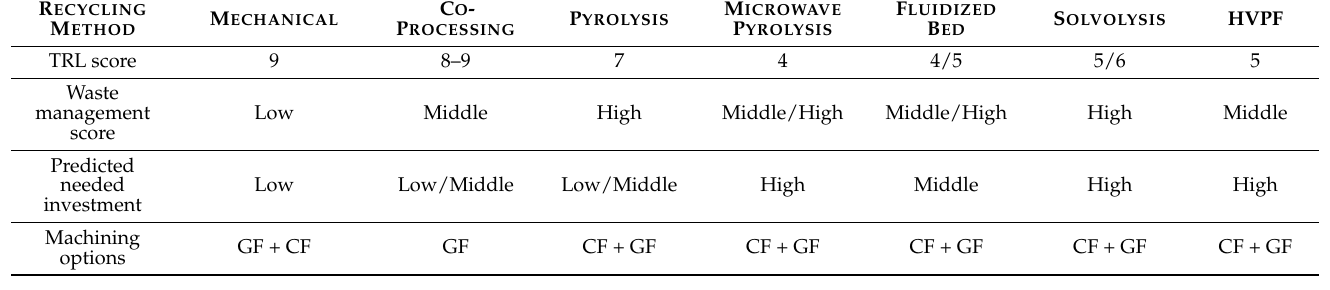
diagram overview. The different scores are evaluated based on comparisons between other research [26,27,31,49,50], the rating from the European waste hierarchy and through communication with the affected industries. The waste management score is categorized into three groups, low, middle and high, which is based on the properties of the various processes, output and TRL but, in particular, on the residual material value, which will be described more Section 4.1. These costs are also indicated and evaluated in the papers from Europe Wind and EtipWind [1,30]. The individual score is indicative and varies among EU recyclers using the same recycling method due to varying processing parameters, capacity and throughput. Table 1. Overview of the current recycling methods (Reproduced from: [26,27,31,49,50]). R ECYCLING